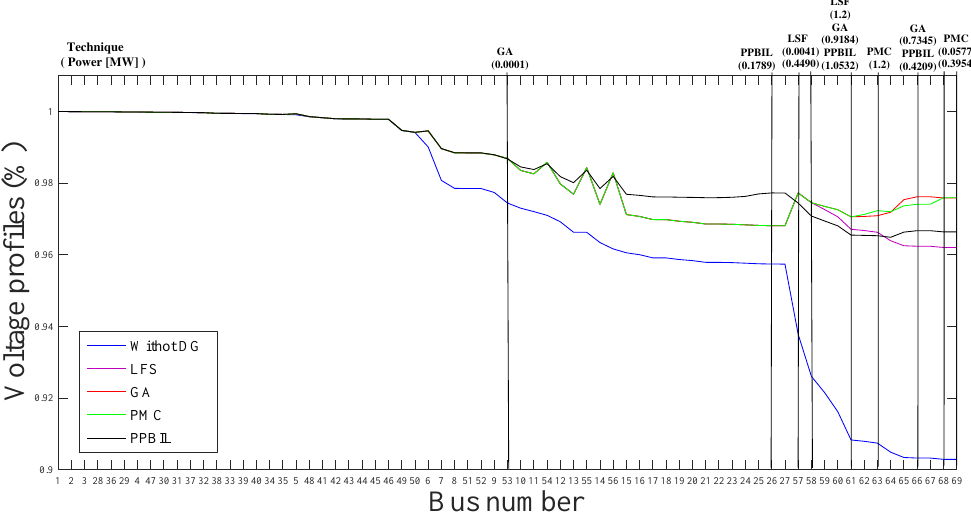
Figure 20. Voltage profiles of test system with the 69 buses ordered from best to worst bus voltage without accounting for